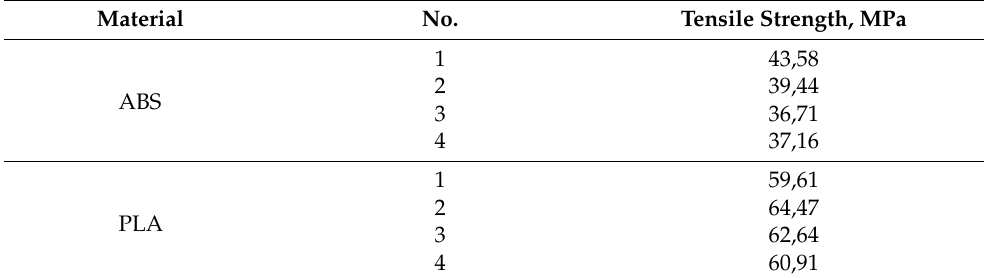
Table 4. The mechanical properties of tensile specimens printed of ABS and